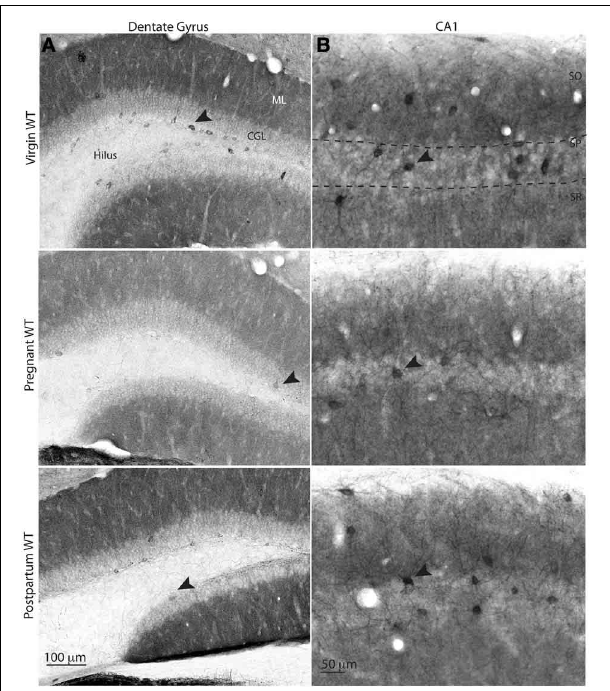
FIGURE 4 | δ -GABA A R immunolabeling of interneurons in the dentate gyrus and area CA1 of the hippocampus at different gestational states. Representativebright-fieldimagesof δ -GABA A Rstaininginthedentategyurs (A) and CA1 (B) . δ -GABA A R specific immunolabeling shows decreased staining of the INs that localize in the inner part of the granule cell layer and within CA1 stratum pyramidale (arrowheads). Some δ -GABA A R labeled INs arevisibleinthemolecularlayerofthedentategyrusinvirginandpostpartum animals,whereasnolabeledINsarevisibleinslicesfrompregnantanimalsin this area.